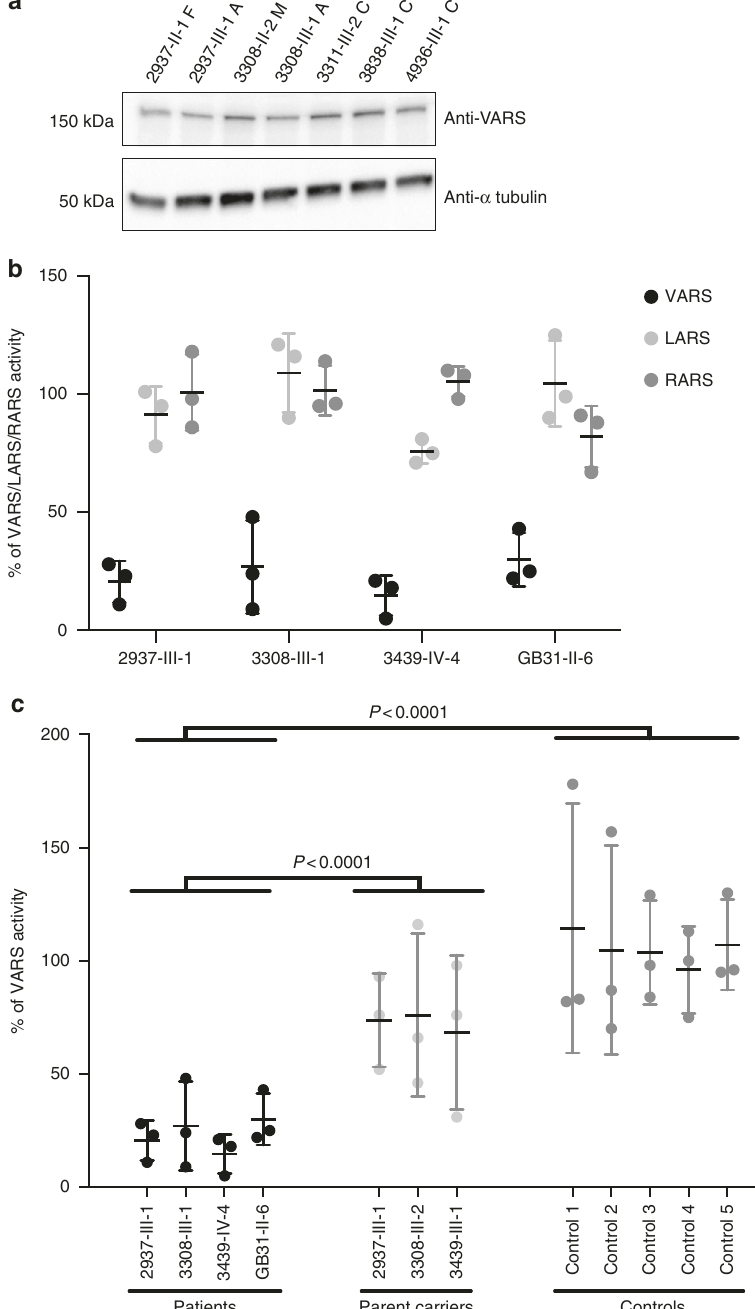
Fig. 3 VARS patient cells show normal VARS protein level, but reduced enzymatic ARS activity. a Western blot of patient or control cells showing retained VARS protein level in affected individuals (2937-III-1A and 3308-III-1A), carrier parents (2937-II-1F and 3308-II-2M), and controls (3311-III-2C, 3838-III-1C, and 4936-III-1C). b VARS, LARS (leucine ARS) and RARS (arginine ARS) aminoacylation activity. VARS activity was speci fi cally reduced in patient cells, normalized to control cells at 100% (from n = 3 replicates, error bars = S.E.M.). c VARS activity in patients compared with carrier parents and controls. Black: patients, light gray: parents of affecteds (obligate carriers of the VARS mutation), dark gray: healthy controls (from n = 3 replicates, error bars = S.E. M). Differences between patients and controls or carriers were calculated based upon the average of the group ( P < 0.0001 for both comparisons, One tailed Student ’ s t -test). Full gel in Supplementary Fig. ef fi cient transfer of charged tRNAs 26 . In addition, there are at least six alternatively spliced VARS transcripts, which are catalytic nulls, but display speci fi c biological activities across a spectrum of cell-based assays, particularly ‘ neutrophil oxidative burst ’ 27 .